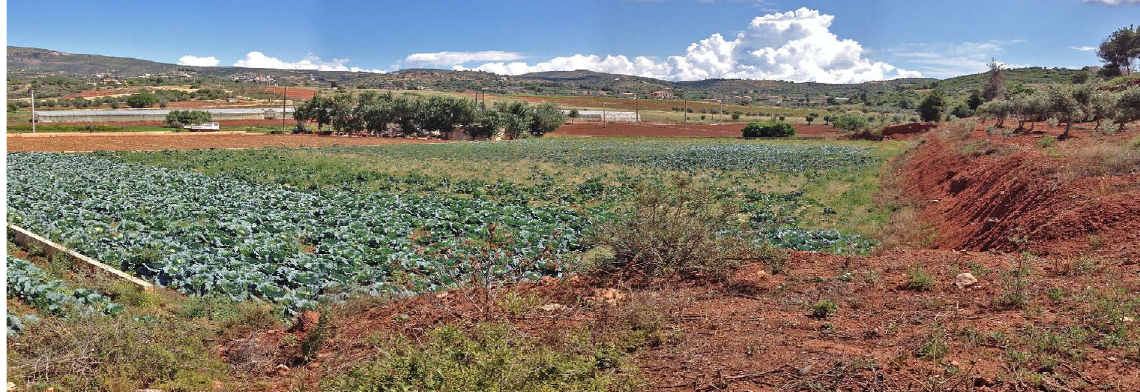
Figure 5. Polje (karstic depression) at Ano Souli with typical Pleistocene deposits rubefied by sub-aerial